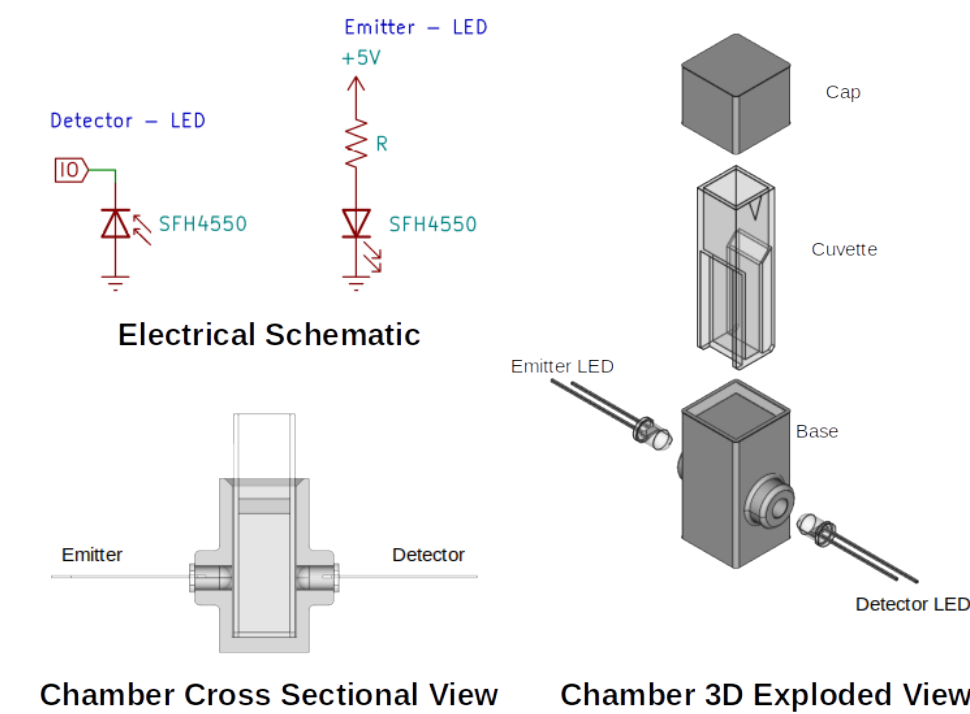
Figure 1. CAD drawings illustrating the electrical schematic/connections and mechanical arrange- ment of the LEDs, cuvette and 3D printed cuvette